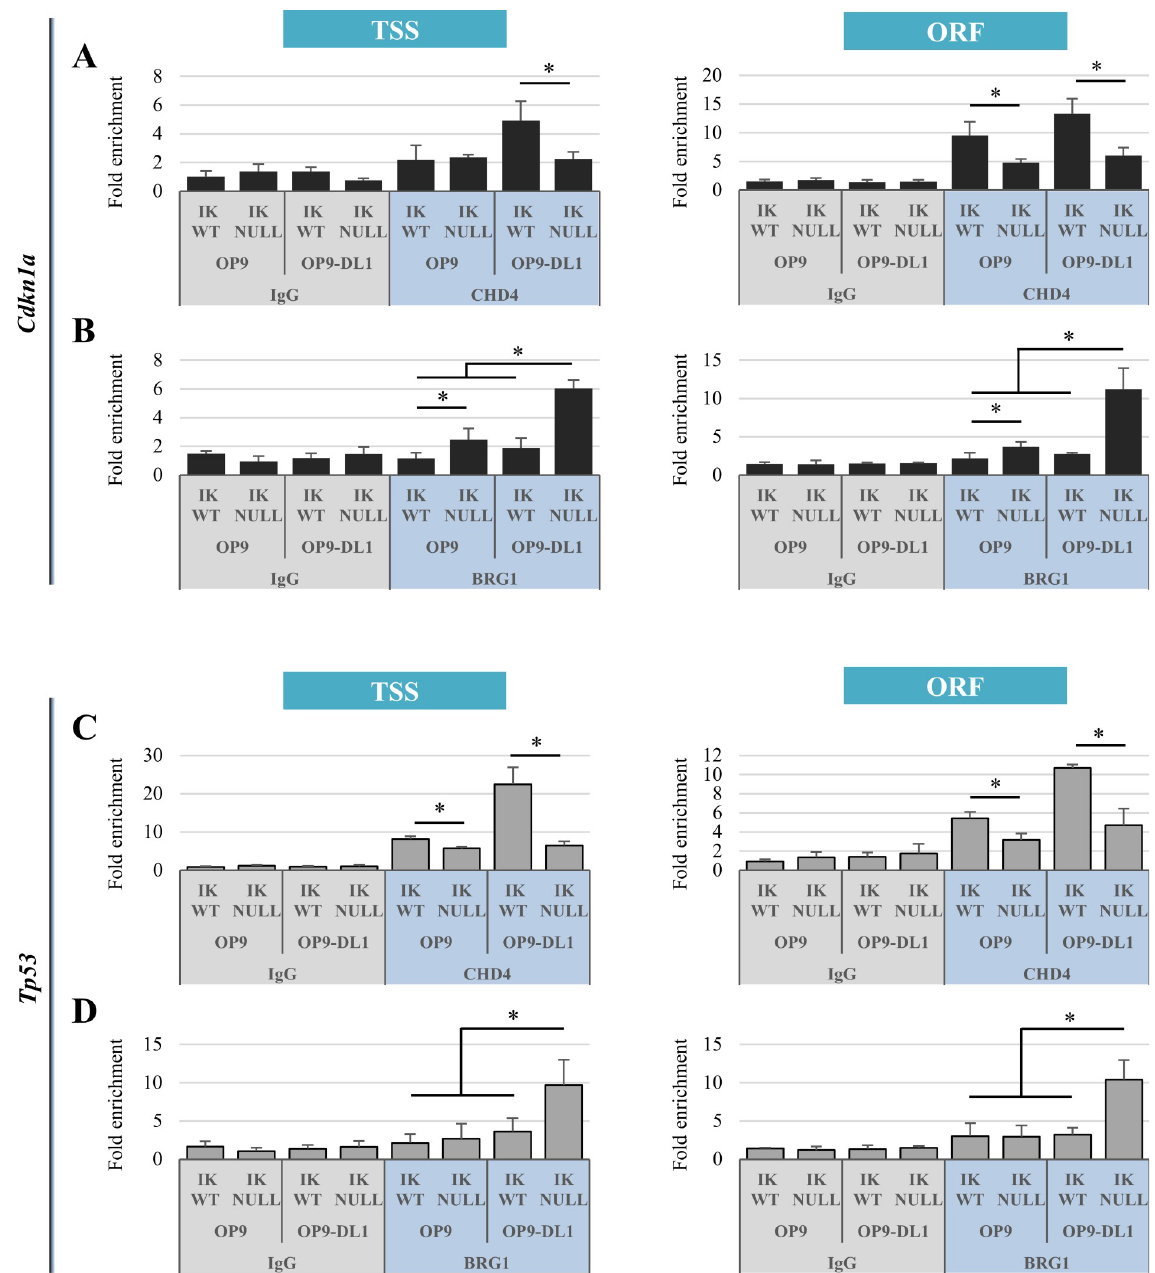
Fig 6. BRG1 and CHD4 recruitment to Cdkn1a and Tp53 genes in Ik WT and Ik Null Ter119 + cells upon NOTCH induction. (A-D) ChIP assays with CHD4, BRG1 antibodies (blue) or isotype-matched IgG (grey) were conducted in Ik WT or Ik Null Ter119 + cells co-cultured with OP9 or OP9-DL1 cells; immunoprecipitated and unbound (input) chromatin samples were used as templates in qPCR analysis with primers specific for Cdkn1a (A, B) or Tp53 (C, D) TSS and ORF; y-axis : fold enrichment levels calculated according to the Pfaffl equation using Thp1 promoter region as internal control, are represented by bars and plotted as the mean ± Standard Deviation of the measurements; a value of 1 indicates no enrichment; data shown are the results of three independent experiments; � : p � 0.05 by Student’s t -test.